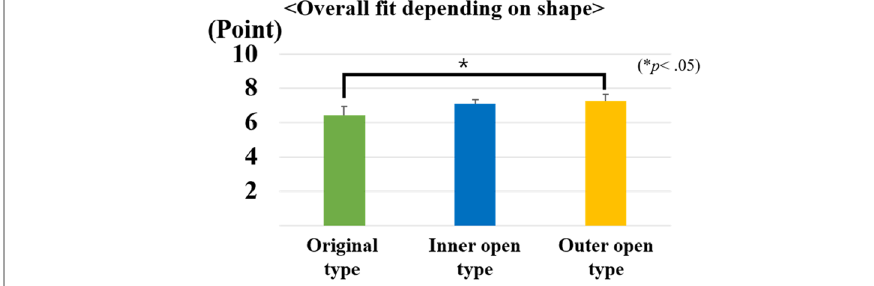
Fig. 9 Overall fit evaluation depending on shape (Bonferroni post hoc analysis method)